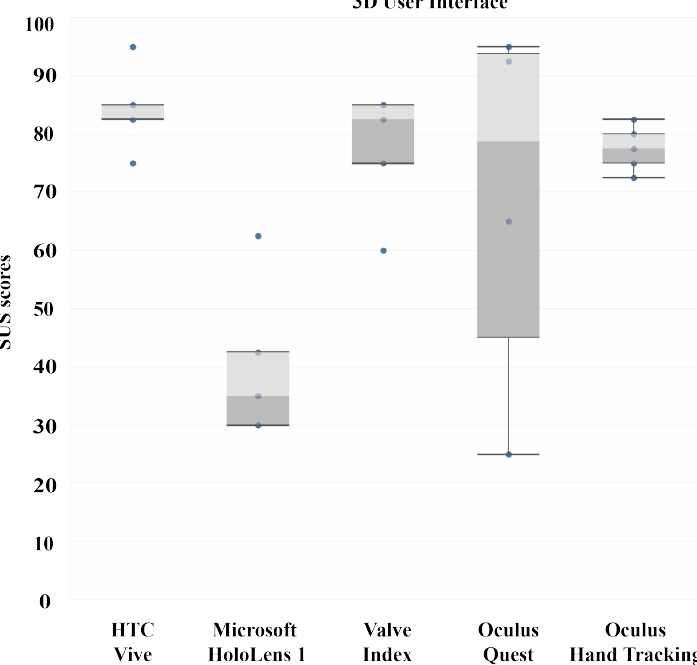
Figure 4. SUS scores data distribution. The box plot indicates the maximum and minimum values, first quartile (q1—darker grey), and third quartile (q3—lighter grey), data points (blue dots), outliers (blue points above and below the whiskers), and the median (i.e., the line between the dark and light gray boxes) within the interquartile